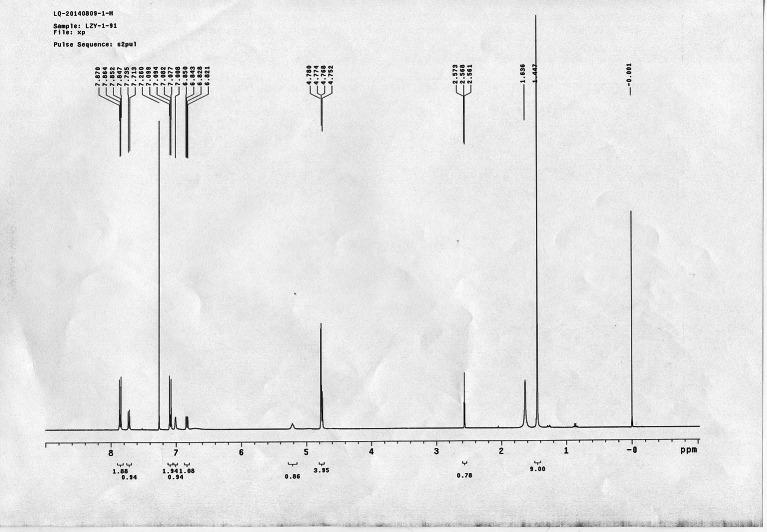
1H NMR spectra of compound 11.